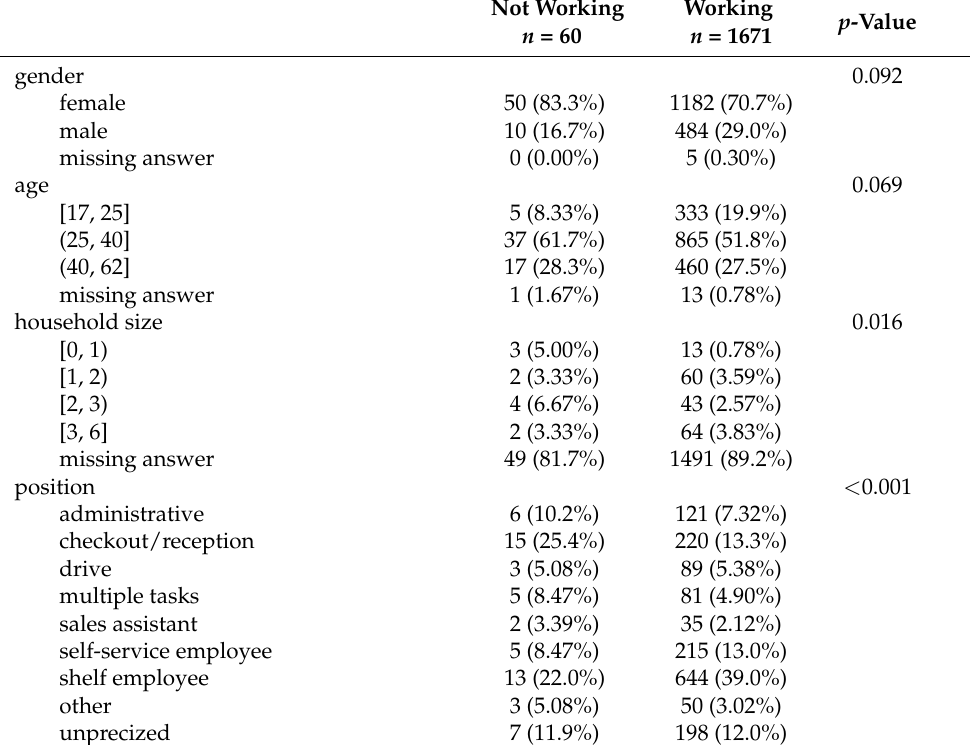
Descriptive statistics for employees working and not working during the lock- down, n = 1746, 15 missing answers ( p -values are provided for the chi-squared or Fisher tests, as